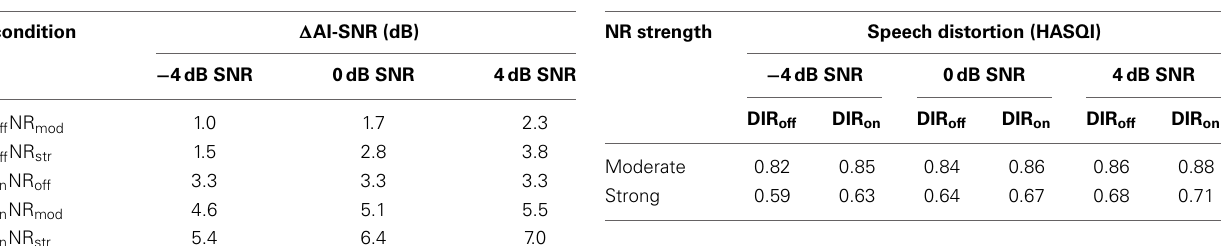
Table 2 | Speech-weighted SNR improvement ( (cid:2) AI-SNR) relative to DIR off NR off for DIR off NR mod , DIR off NR str , DIR on NR off , DIR on NR mod , and DIR on NR str and input SNRs of − 4, 0, and 4dB.